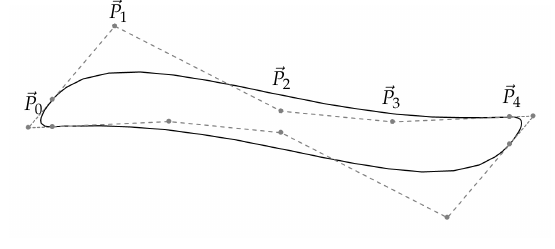
Figure 20. Point symmetrical